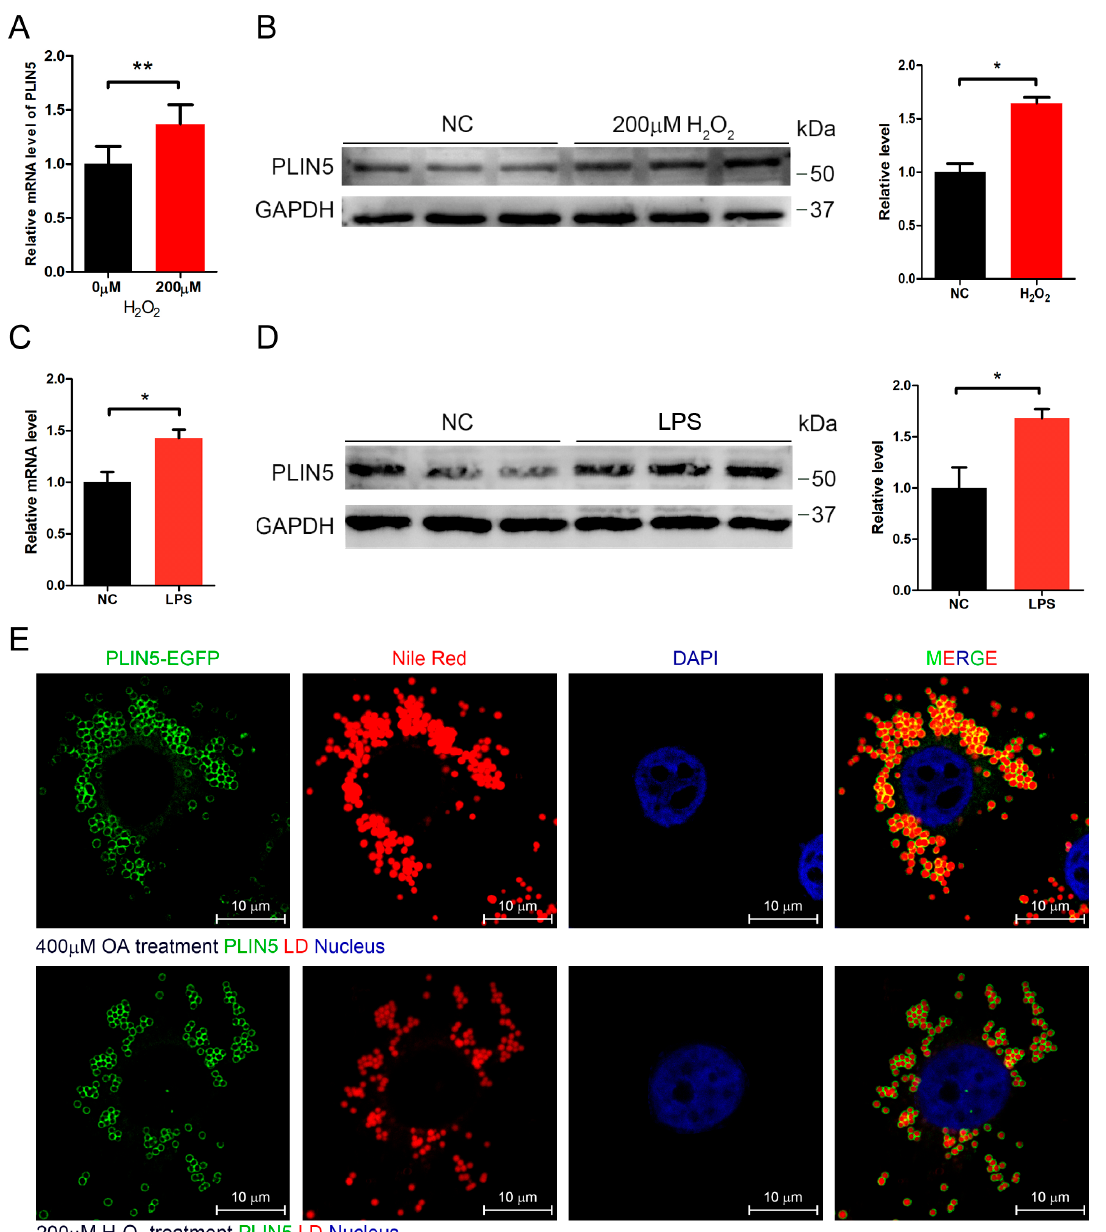
Figure 2. Hydrogen peroxide or lipopolysaccharide (LPS) treatment enhanced the expression of PLIN5 . Hydrogen peroxide and LPS were used to induce cellular oxidative stress. ( A ) mRNA level of PLIN5 in cells with H 2 O 2 treatment or control (phosphate bu ff er saline, PBS). ( B ) Western Blot analysis of PLIN5 protein levels in cells with H 2 O 2 treatment or control (PBS). ( C ) mRNA level of PLIN5 in cells with LPS treatment or control (PBS). ( D ) Western Blot analysis of PLIN5 protein levels in cells with LPS treatment or control (PBS). ( E ) H 2 O 2 treatment did not change the localization of PLIN5 . PLIN5 localization analysis of cells with 400 µ M oleic acid medium or H 2 O 2 treatment. Green, PLIN5-EGFP; red, lipid droplets; blue, nucleus. Bar, 10 µ m. These experiments were performed in triplicate. * p < 0.05; and ** p < 0.01.